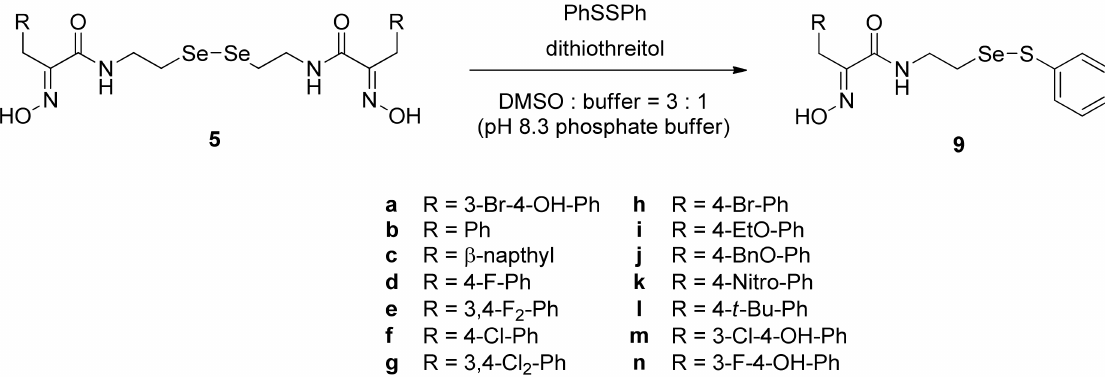
Figure 3. Synthetic half-selenopsammaplin A (HSPA) method and its analogs from various selenopsammaplin A